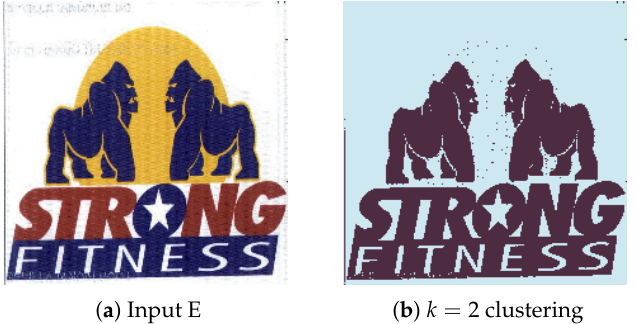
Figure 14. ( a ) Experiment E input; ( b ) Experiment E K-Means clustering ( k = 2).